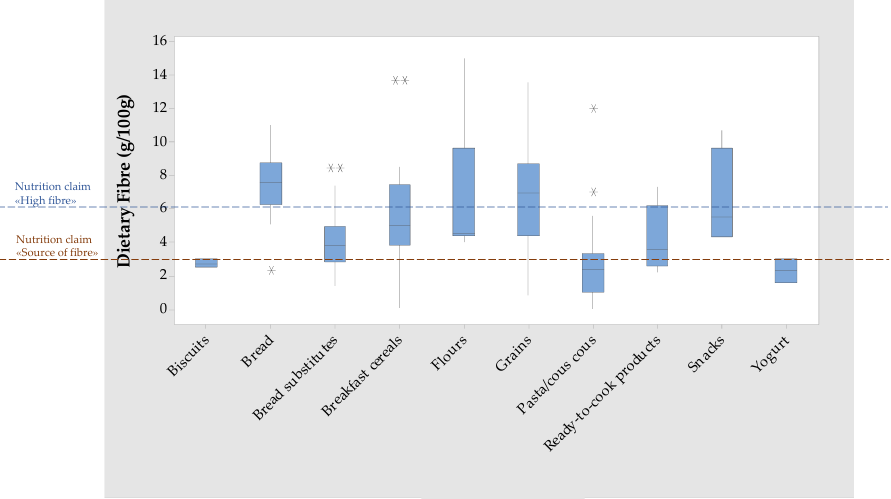
Figure 3. Boxplot for dietary fibre (g/100 g) in quinoa food categories and reference values for the claims “source of fibre” and “high fibre”.